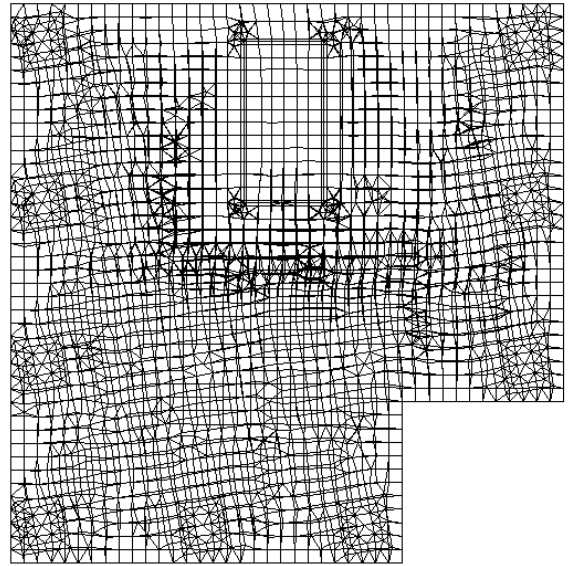
Figure 7 . Zoomed meshed model for FEM analysis (top